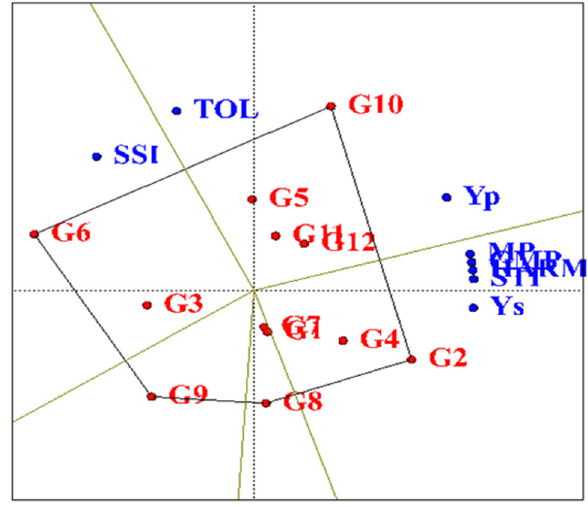
Figure 7. Diagram of a polygon diagram of the reaction of maize hybrids to drought-tolerance indices studied under water stress conditions. Yp: Yield under normal condition, Ys: yield under drought condition, TOL: Tolerance, MP: Mean Productivity, GMP: Geometric Mean Productivity, HARM: Harmonic Mean Productivity, SSI: Stress Susceptibility Index, STI: Stress Tolerance Index. G1: KSC703, G2: KSC260, G3: KSC705, G4: KSC400, G5: KSC706, G6: KSC704, G7: KSC707, G8: DC370,